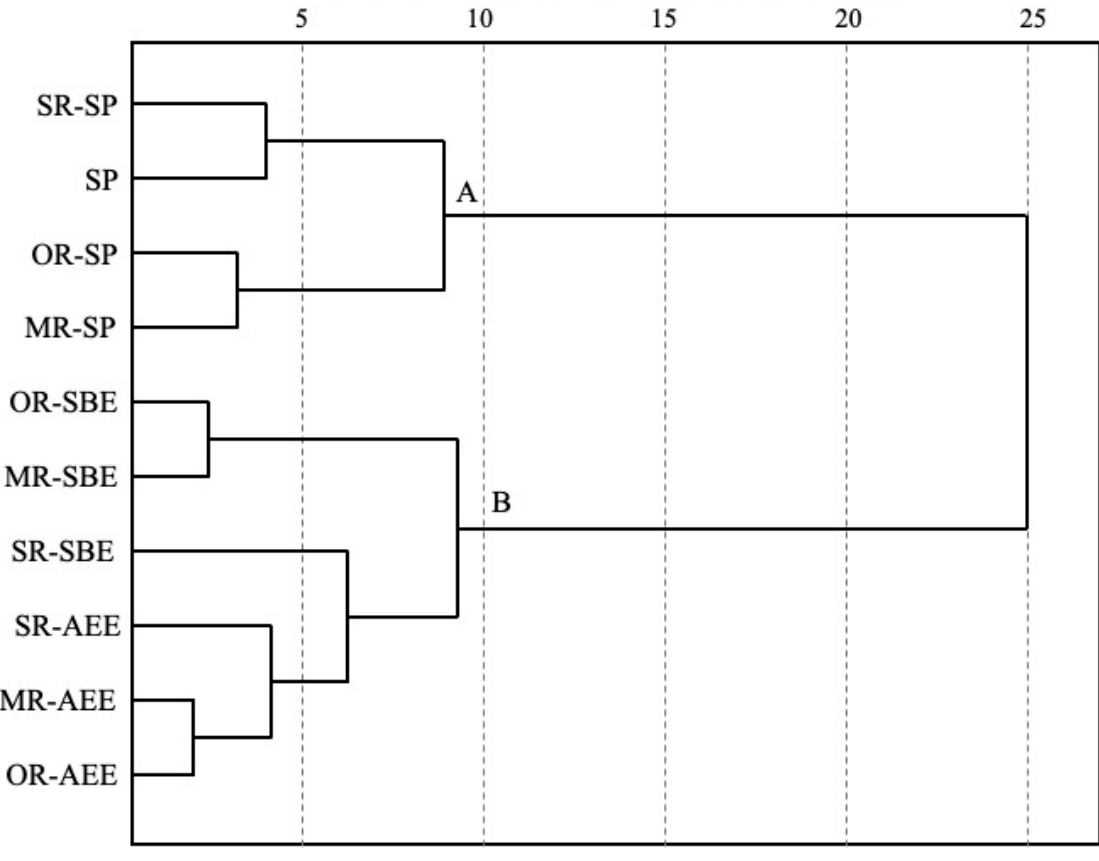
Figure 1. Hierarchical cluster analysis of walnut oils.